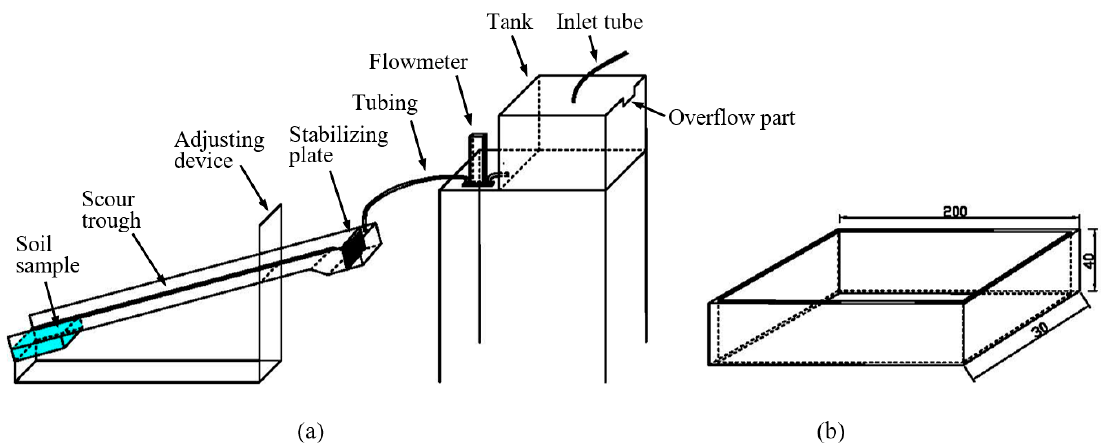
Figure 1. Schematic diagram of the experimental setup for the flume apparatus used to measure soil detachment. ( a ) Flume apparatus. ( b ) Cutting ring. Scour trough length is 1 m. Adjusting device provides for manual adjustment of the scour trough. Cutting ring wall thickness is 2 mm. Dimensions are in mm.